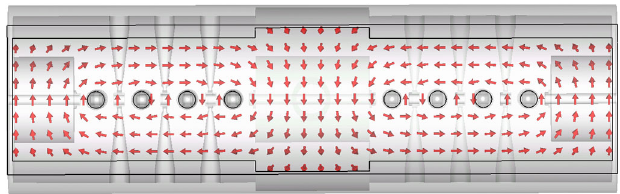
FIG. 23. The magnetic field distribution along the cut A - A 0 of Fig.